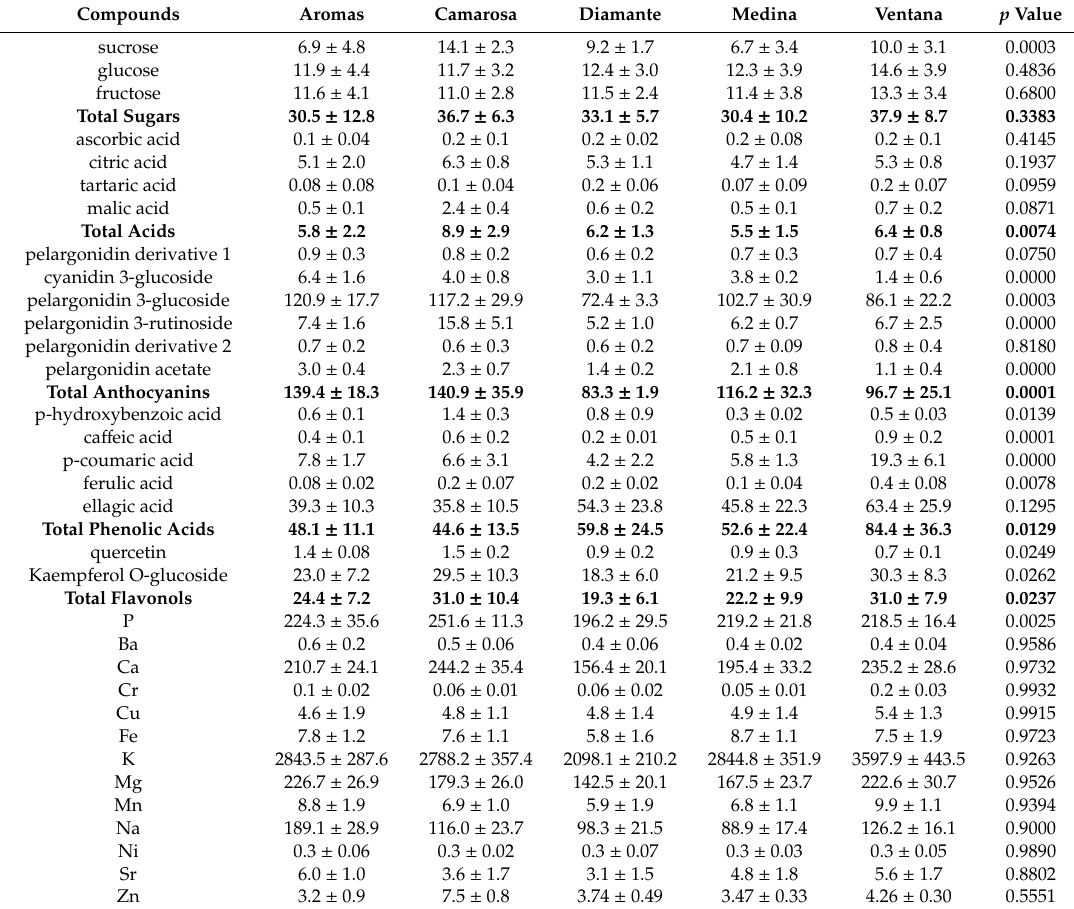
Table 1. Concentrations (expressed as the mean ± standard deviation) of sugars (g kg − 1 ), organic acids (g kg − 1 ), phenolic compounds (mg kg − 1 ), and mineral elements (mg kg − 1 ) in each strawberry cultivar, and p values obtained by